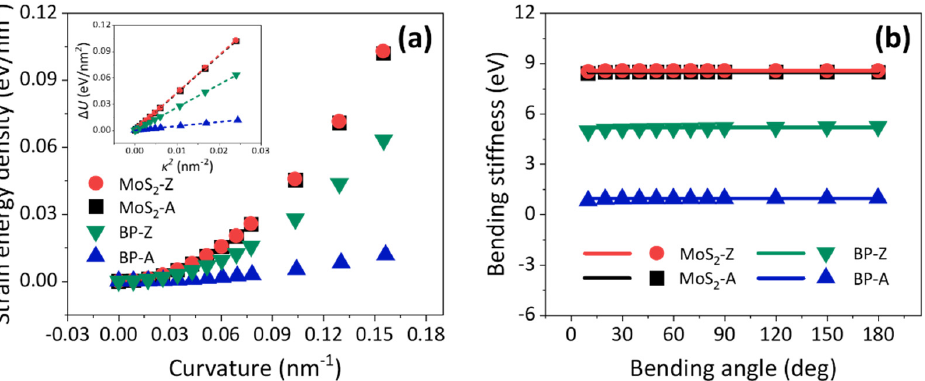
Figure 2. ( a ) The relationships between the strain energy density and curvature of SLBP and SLMoS 2 . The inset shows the relation between the strain energy density ( ∆ U ) and curvature square ( κ 2 ). The dotted lines are the fitting lines. ( b ) The variations of bending stiffnesses of SLBP and SLMoS 2 with the bending angles. The scatters and solid lines are the computational results of two-point and multi-point fittings, respectively.